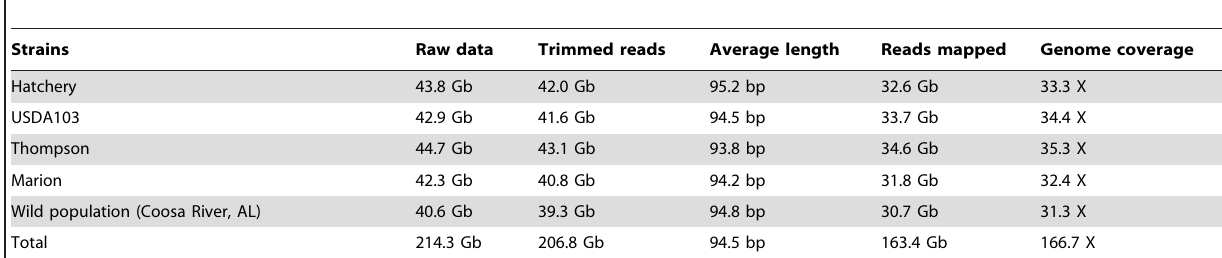
Table 1. Summary of genomic data generation of channel catfish using Illumina HiSeq 2000, including raw data, trimmed reads, average length, reads mapped and genome coverage by